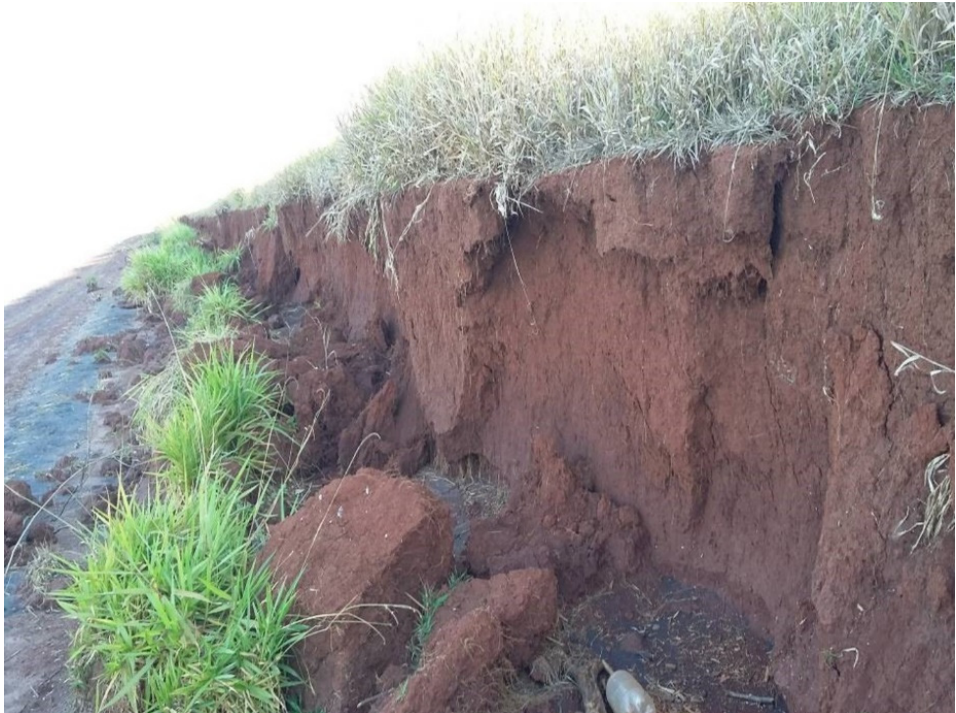
Figure 2. Erosion by the impact of waves on the margin of the Porto Colômbia Hydroelectric Power Plant (HPP) reservoir (July 2016).